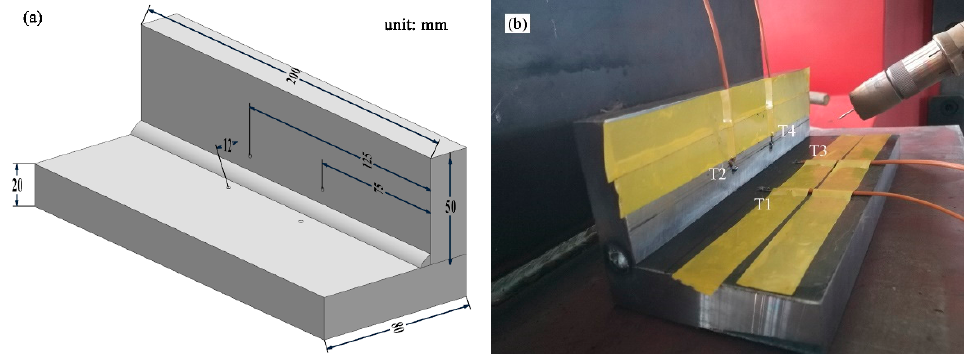
Figure 2. Diagram of the welding and temperature of measuring: ( a ) 3D drawing of the workpiece; ( b ) welding picture.